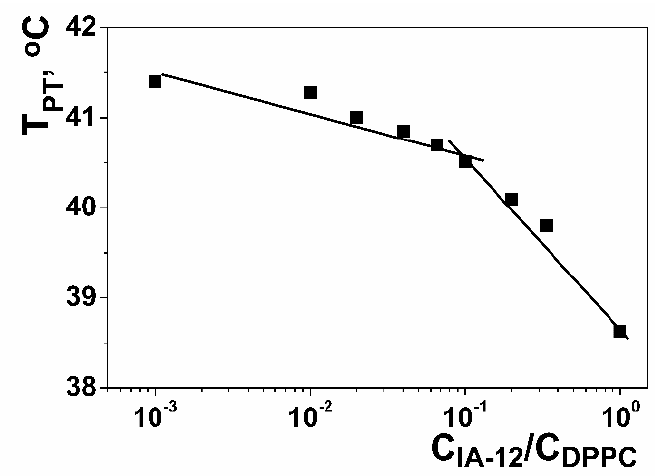
Figure 12. DPPC main phase transition temperature versus the amphiphile/lipid molar ratio plot for the IA-12/DPPC binary system.